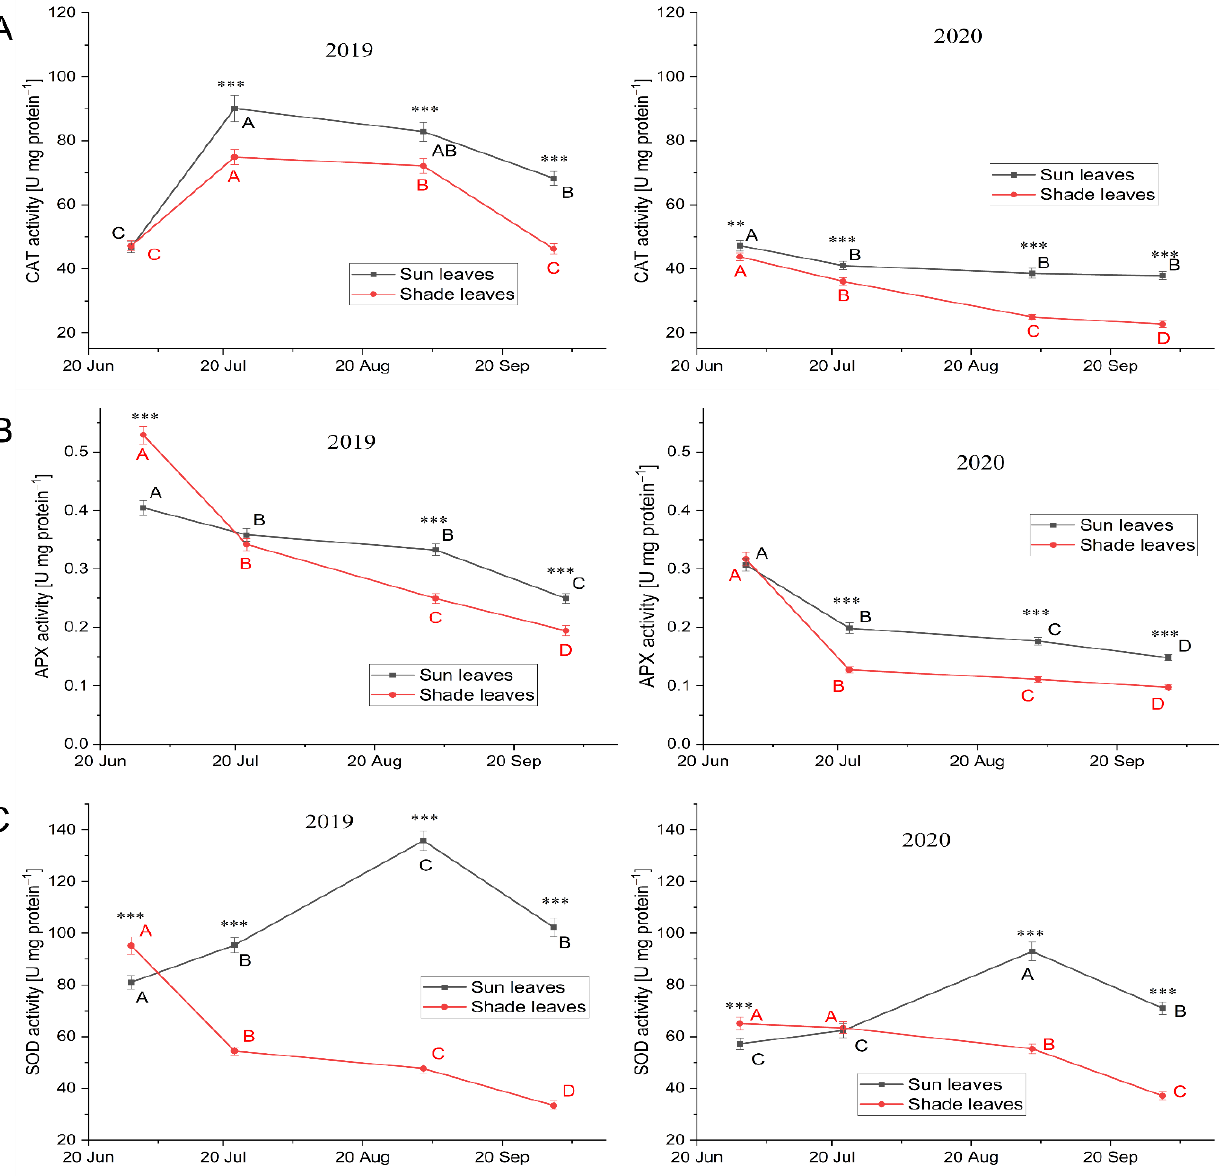
Figure 7. Changes in catalase ( A ), ascorbate peroxidase ( B ), and superoxide dismutase ( C ) activities in the sun and shade senescing beech ( Fagus sylvatica L.) leaves. Analyses were performed for sun (black line) and shade (red line) leaves in 2019 and 2020. Each point is the mean of 60 measurements (±standard error). For each type of leaves, means with different uppercase letters differ significantly at p < 0.05. For each date, means with asterisks differ significantly at ** — p < 0.01 and *** — p < 0.001.